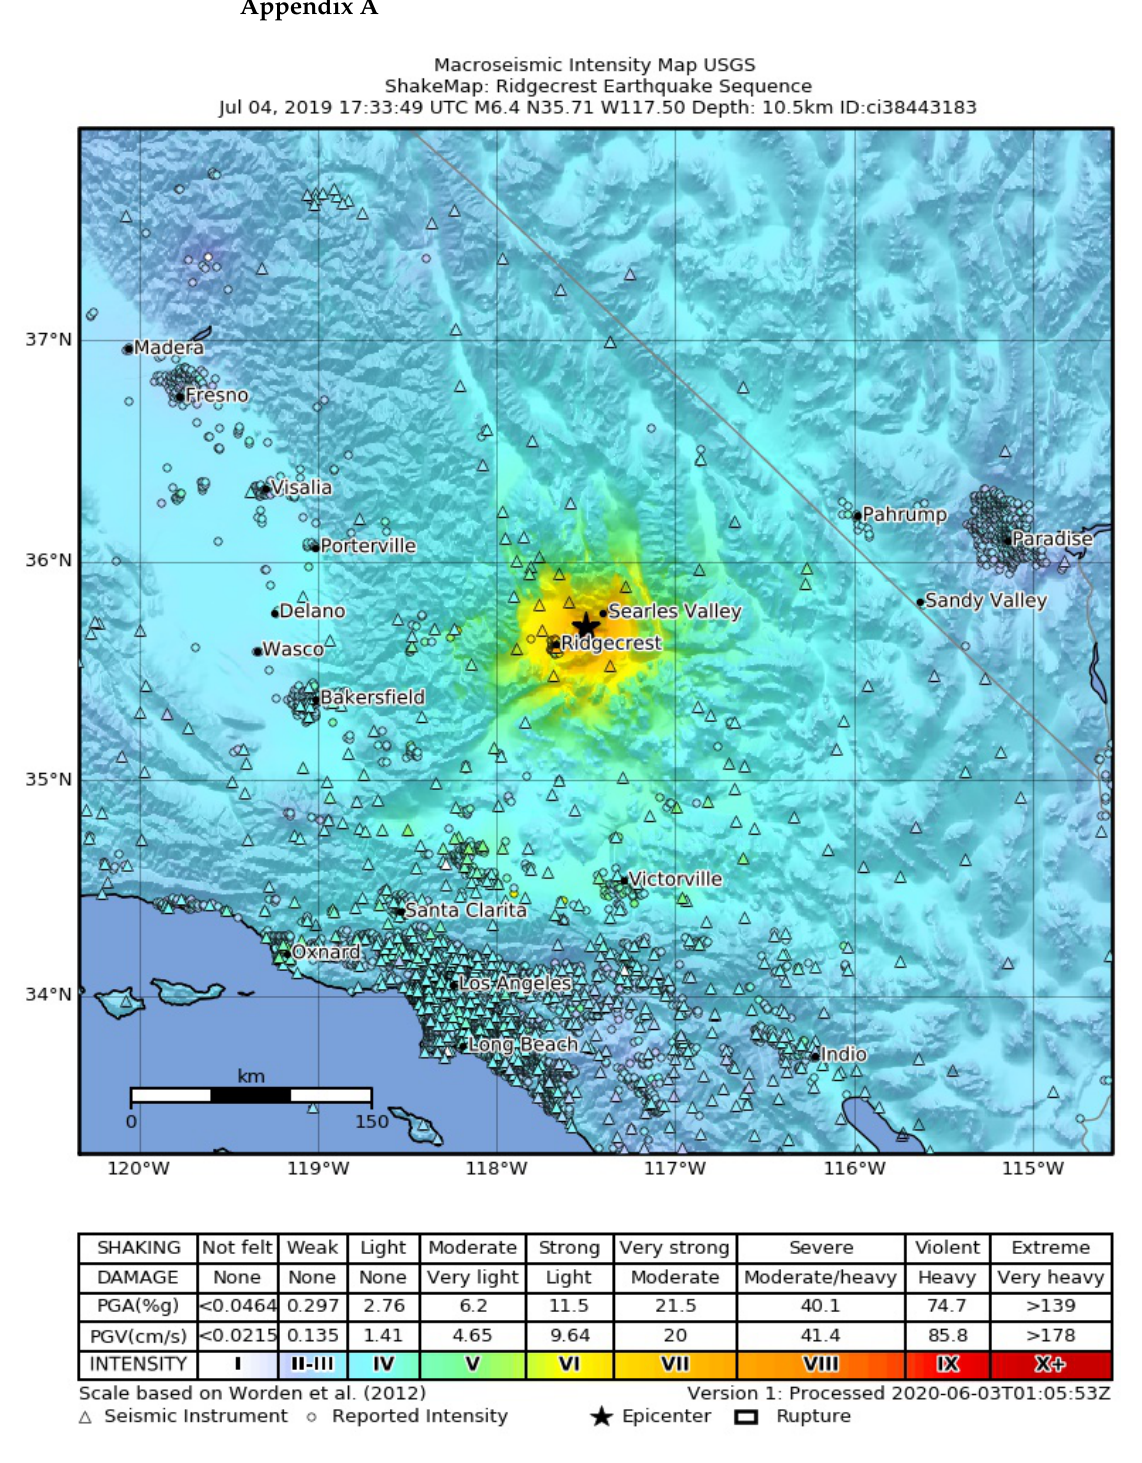
Figure A1. Shakemap of the mainshock obtained from